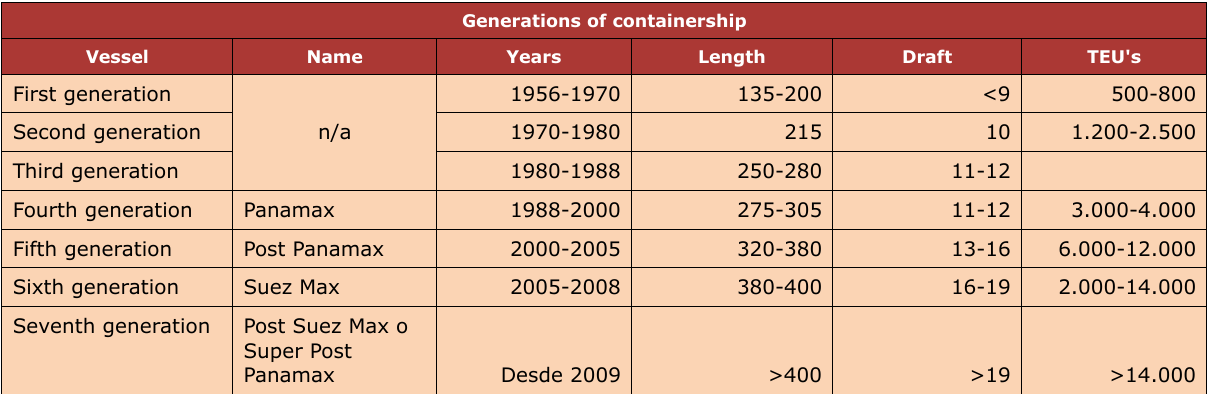
Table 3. Increase of size of the ship container